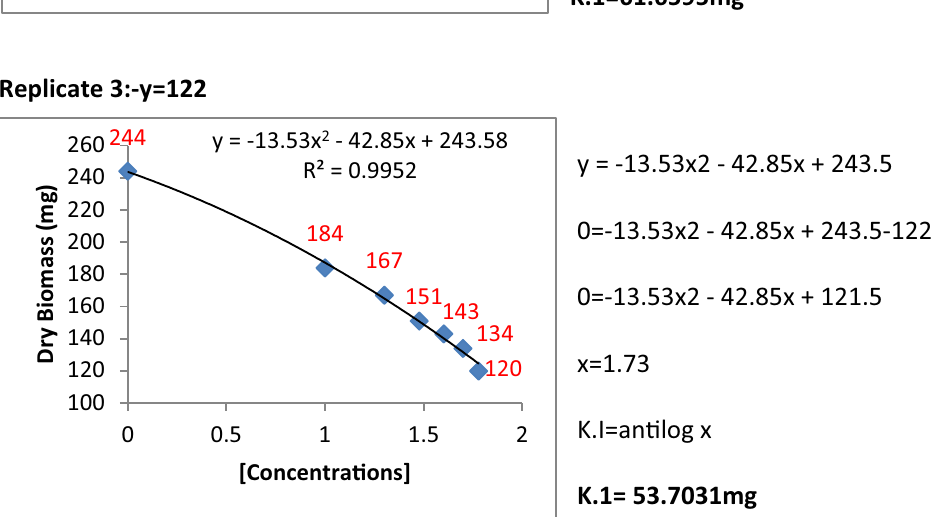
Figure 15. Kinetic constants of inhibition of P. herbarum by metabolites of P. oxalicum (3